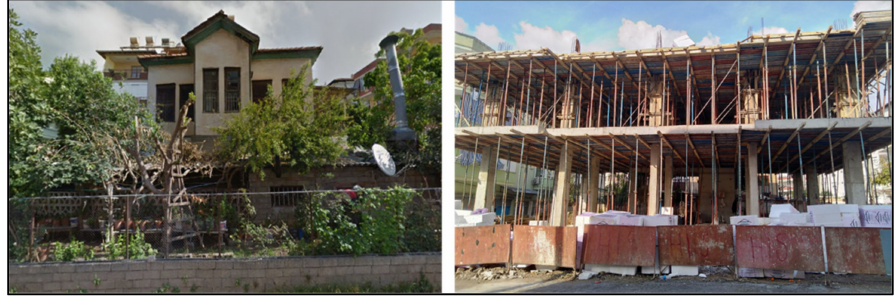
Figure 16. An example of a destroyed and redeveloped historic building in Turkey (It was not listed as a “historic building” before the destruction. The construction started in December